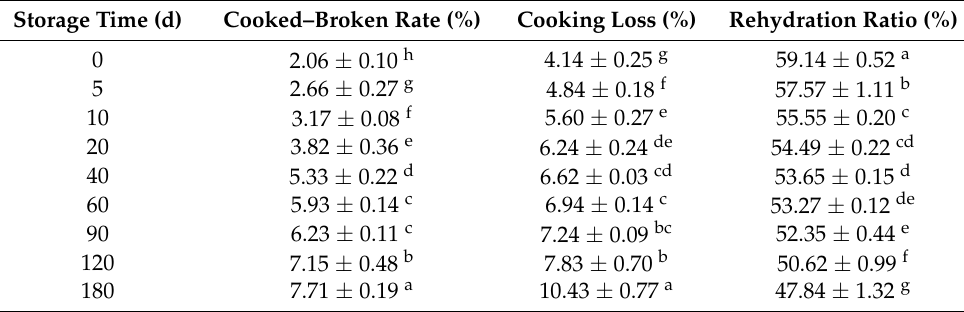
Table 1. Changes in cooking quality of semi-dried rice noodles during